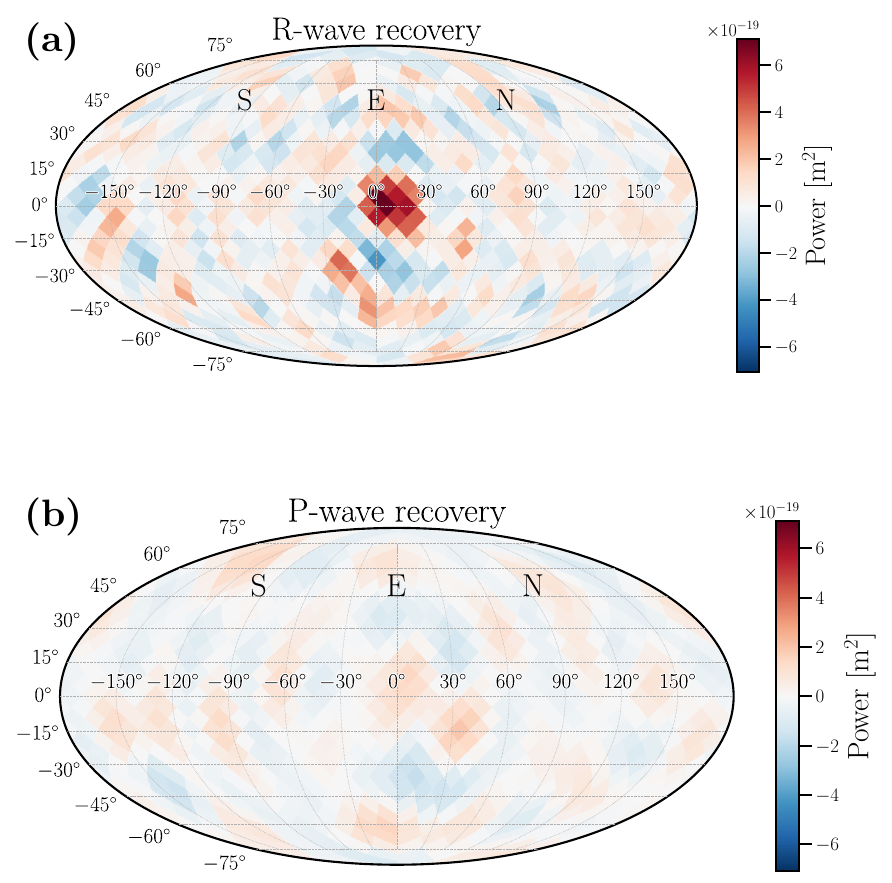
Figure 7. Recovery of 1.5 Hz source from 2 October 03:00–04:00 UTC for Rayleigh waves ( a ), and P waves ( b ). We see that there is a strong peak between 0 and 30 ◦ for R waves, while for P waves, there is no obviously preferred direction. Note that we plot the R-wave recovery in 2D, even though only one (azimuthal) angle defines the wave propagation direction. This is done as a cross-check—if incorrect R-wave phase velocity is used in the recovery, the recovered spot could appear off the x-axis in this